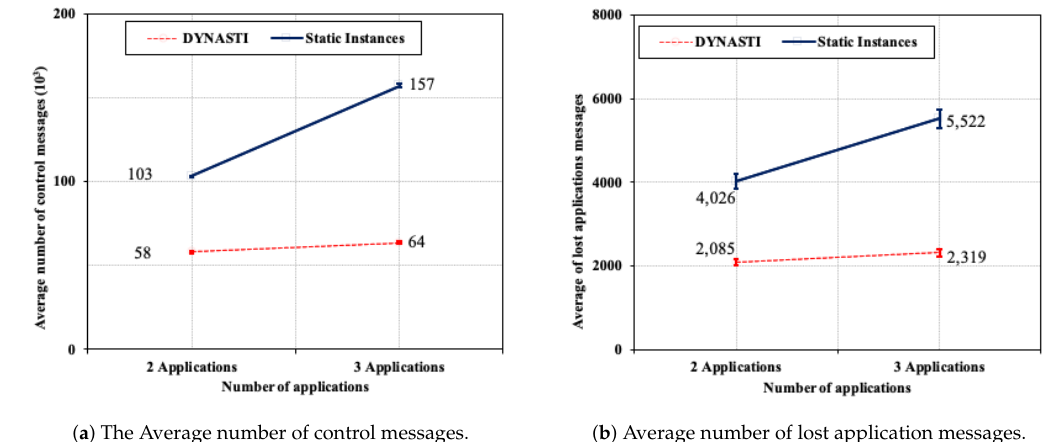
Figure 10. The average number of control messages and average number of lost application messages.